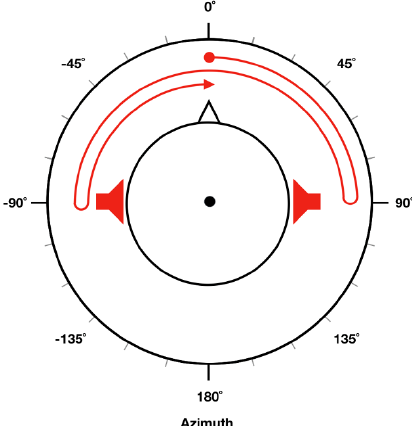
Figure 1. Generation of spatially moving pure-tone stimuli. In order to make a pure-tone sound stimulus move along the trajectory shown as a red-headed arrow, different sound intensities were applied to each ear based on current location of the sound source.